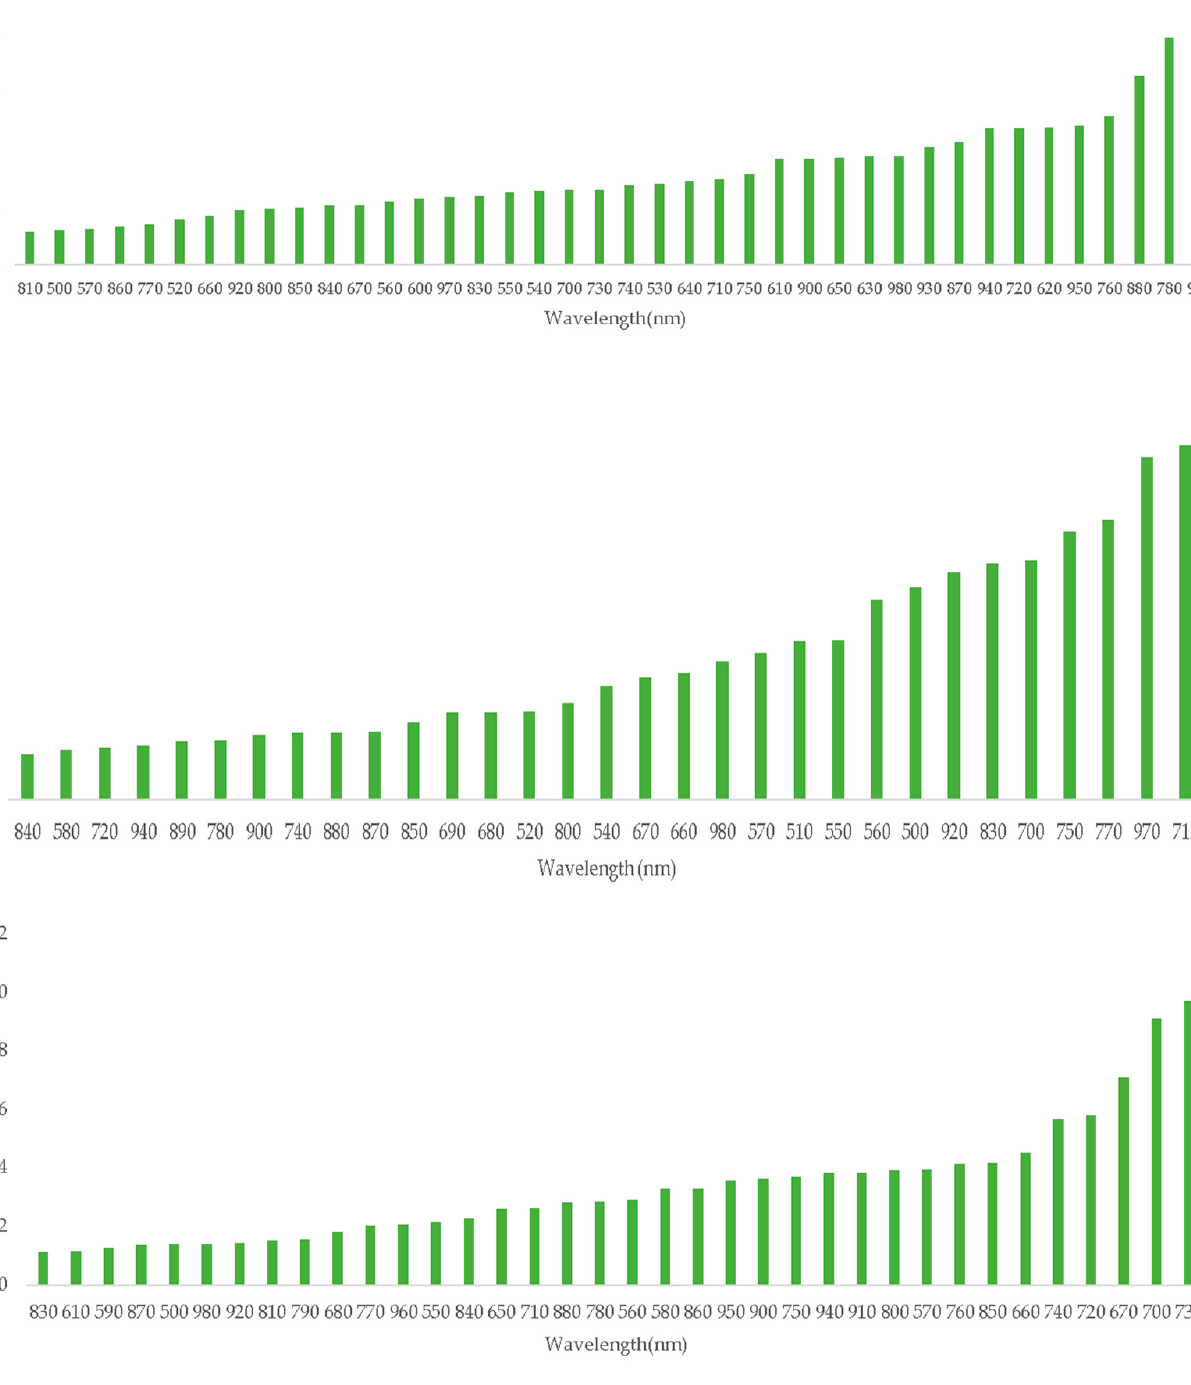
Figure 2. Wavelengths VIP scores higher than 1 for N ( top ), K ( middle ) and B ( bo tt om ).